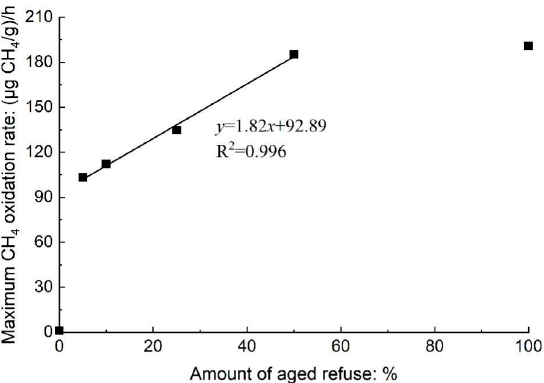
Figure 3. Relationship between maximum methane oxidation rate and amount of aged